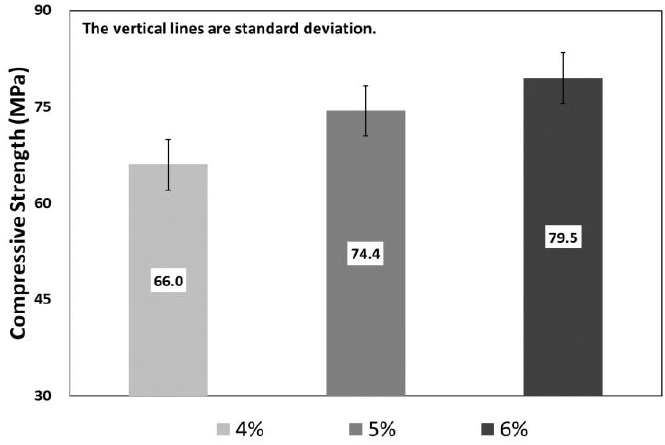
Figure 4. Compressive strength test results with respect to the fiber volume fraction.